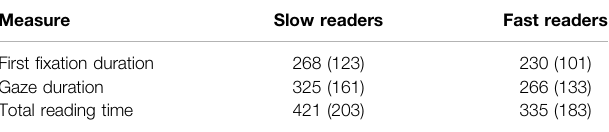
TABLE 1 | Mean fi rst fi xation duration, gaze duration and total reading time (in milliseconds) on all words in the texts for slow and fast readers (standard deviations in